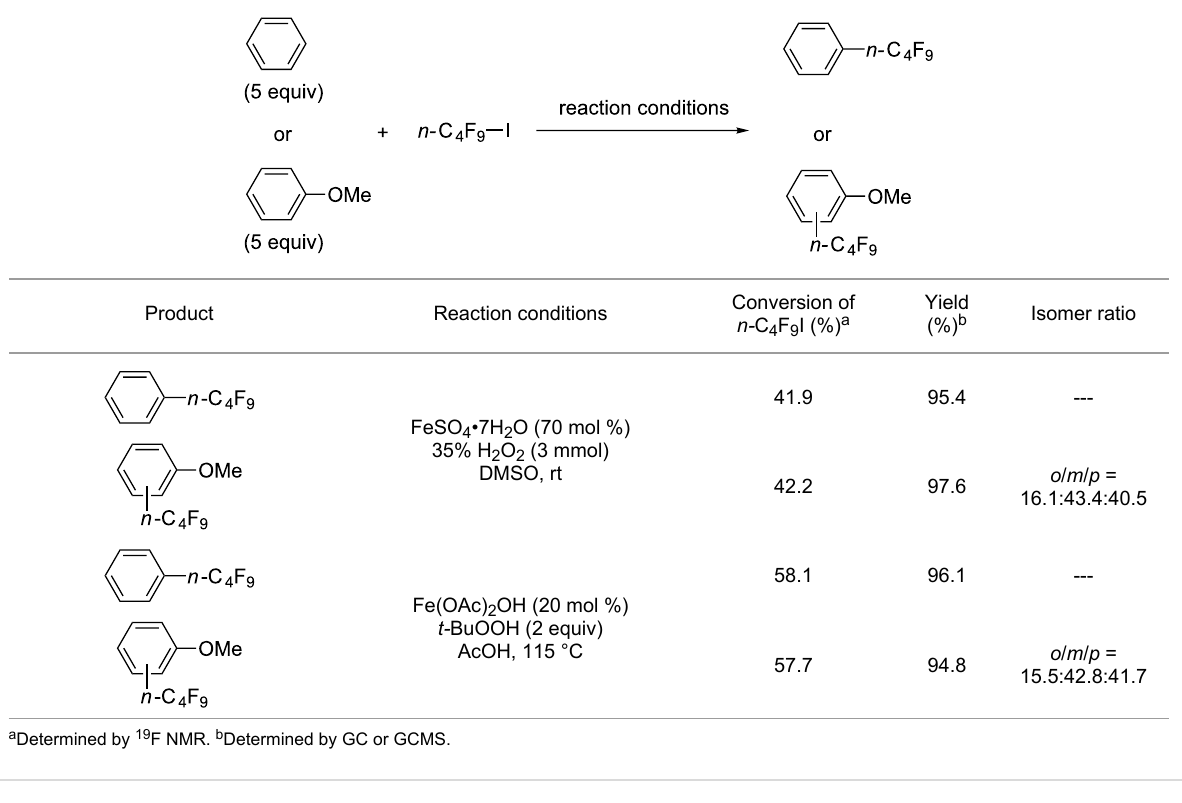
Table 38: Perfluoroalkylation of benzenes or anisoles employing Fenton’s reagent